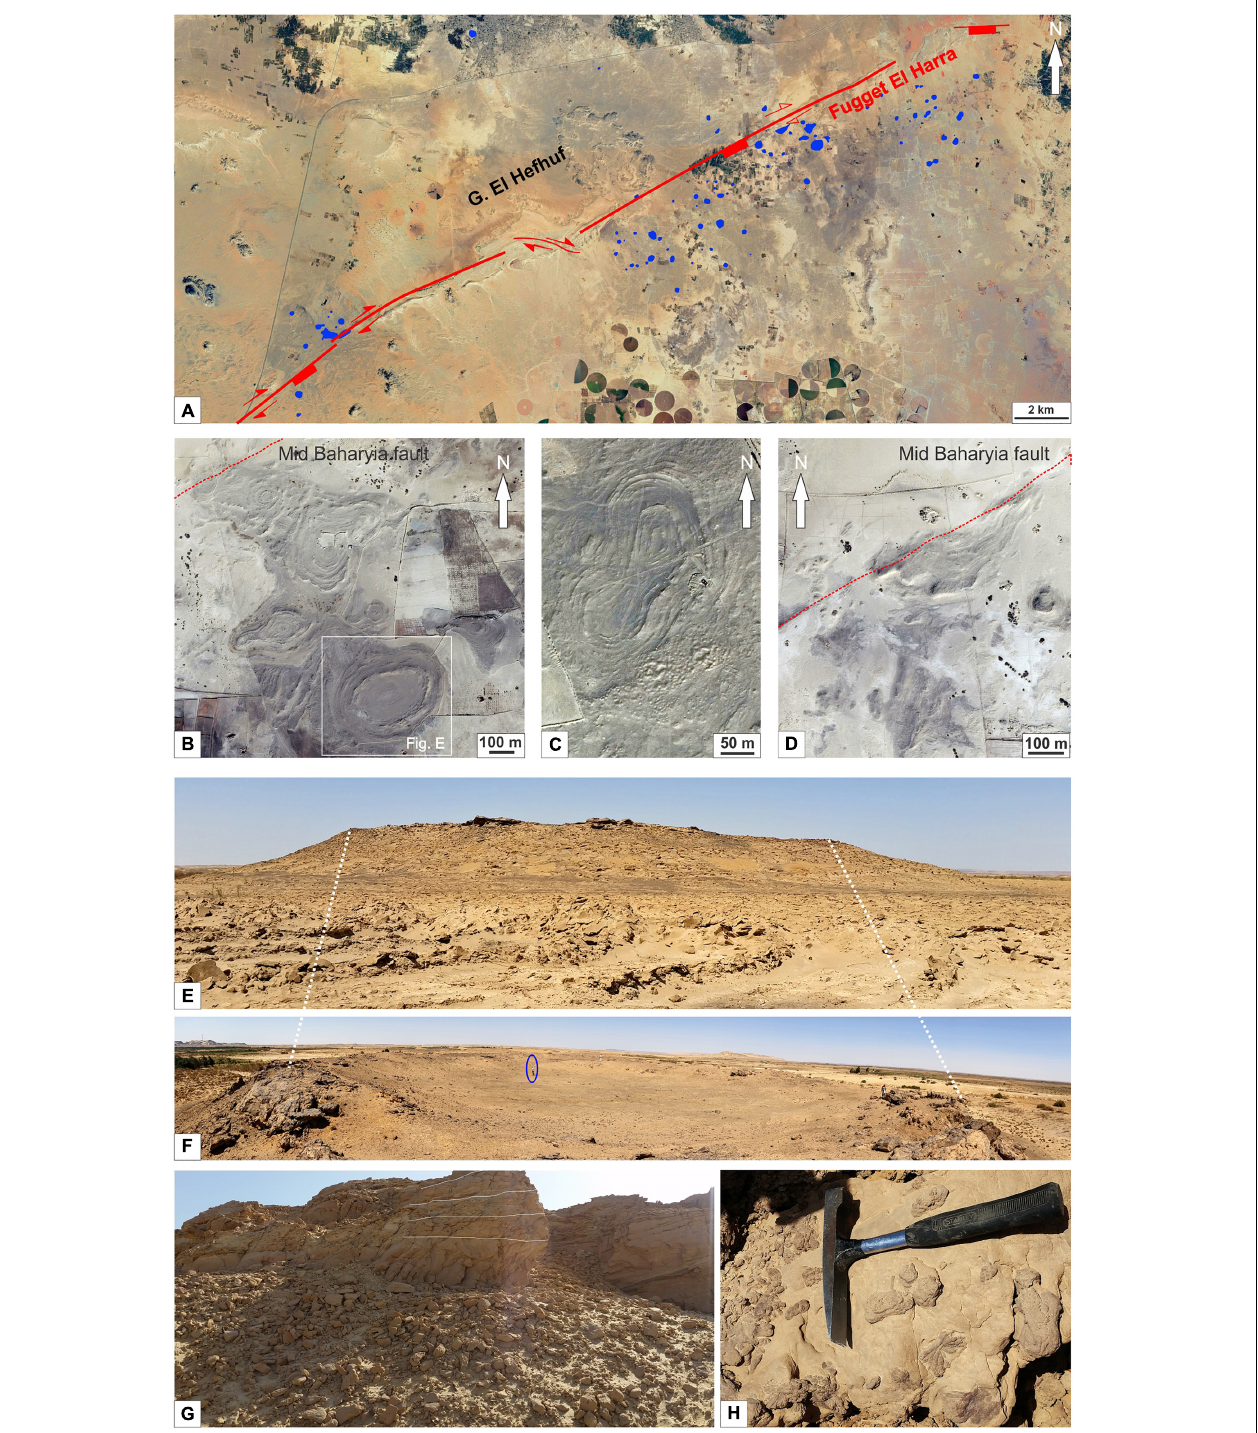
FIGURE 4 | Circular concentric structures in the Bahariya Depression. (A) Satellite image of the Bahariya Depression with CS mapped (framed in blue). Their concentration increases approaching the Bahariya fault (traced with red line) and is higher in the southern part of it. (B–D) Satellite image examples of CS fields. Note the internal ring pattern; the central part of these structures may occasionally be filled with sandy sediments. (B) Subcircular CS with increased deformation (from bottom to top) approaching the fault zone (indicated with red line). (C) Twinned and deformed CS. (D) Sharp cut of CS at the intersection with the fault (indicated with red line). (E,F) Field images of CS. Seen from aside (E) are visible the steeper external flanks while the internal structure (F) consist of a basin-like depression (man for scale). (G) Detail of one of the external flanks showing the layered sedimentary host rocks; (H) detail of one of the Ba-cemented sandstone beds with numerous desert roses on the